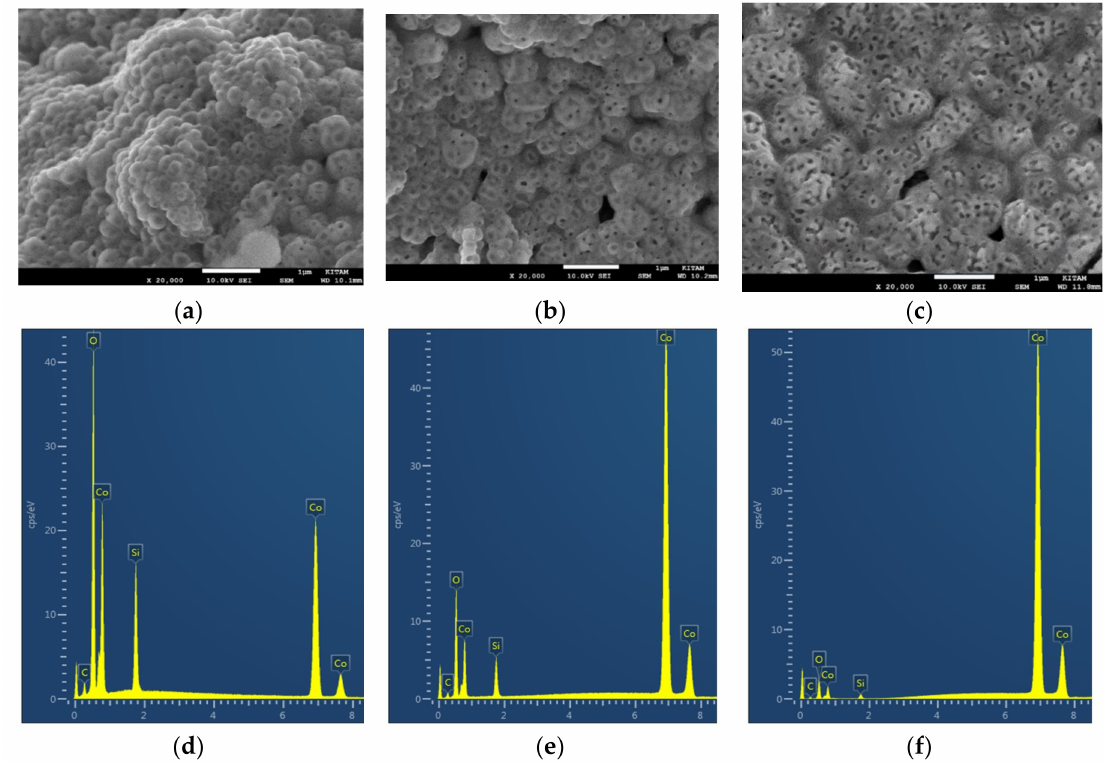
Figure 22. EDX- spectra and the corresponding SEM images of the Co / Si = 2 catalyst at various sites. ( a , d ) Lowest cobalt site with [Co] = 0.248; [Si] = 0.085; [O] = 0.667; ( b , e ) Average cobalt site with [Co] = 0.659; [Si] = 0.043; [O] = 0.298; ( c , f ) Highest cobalt site with [Co] = 0.933; [Si] = 0.007; [O] = 0.060. Scale bar = 1 µ m in all SEMs.